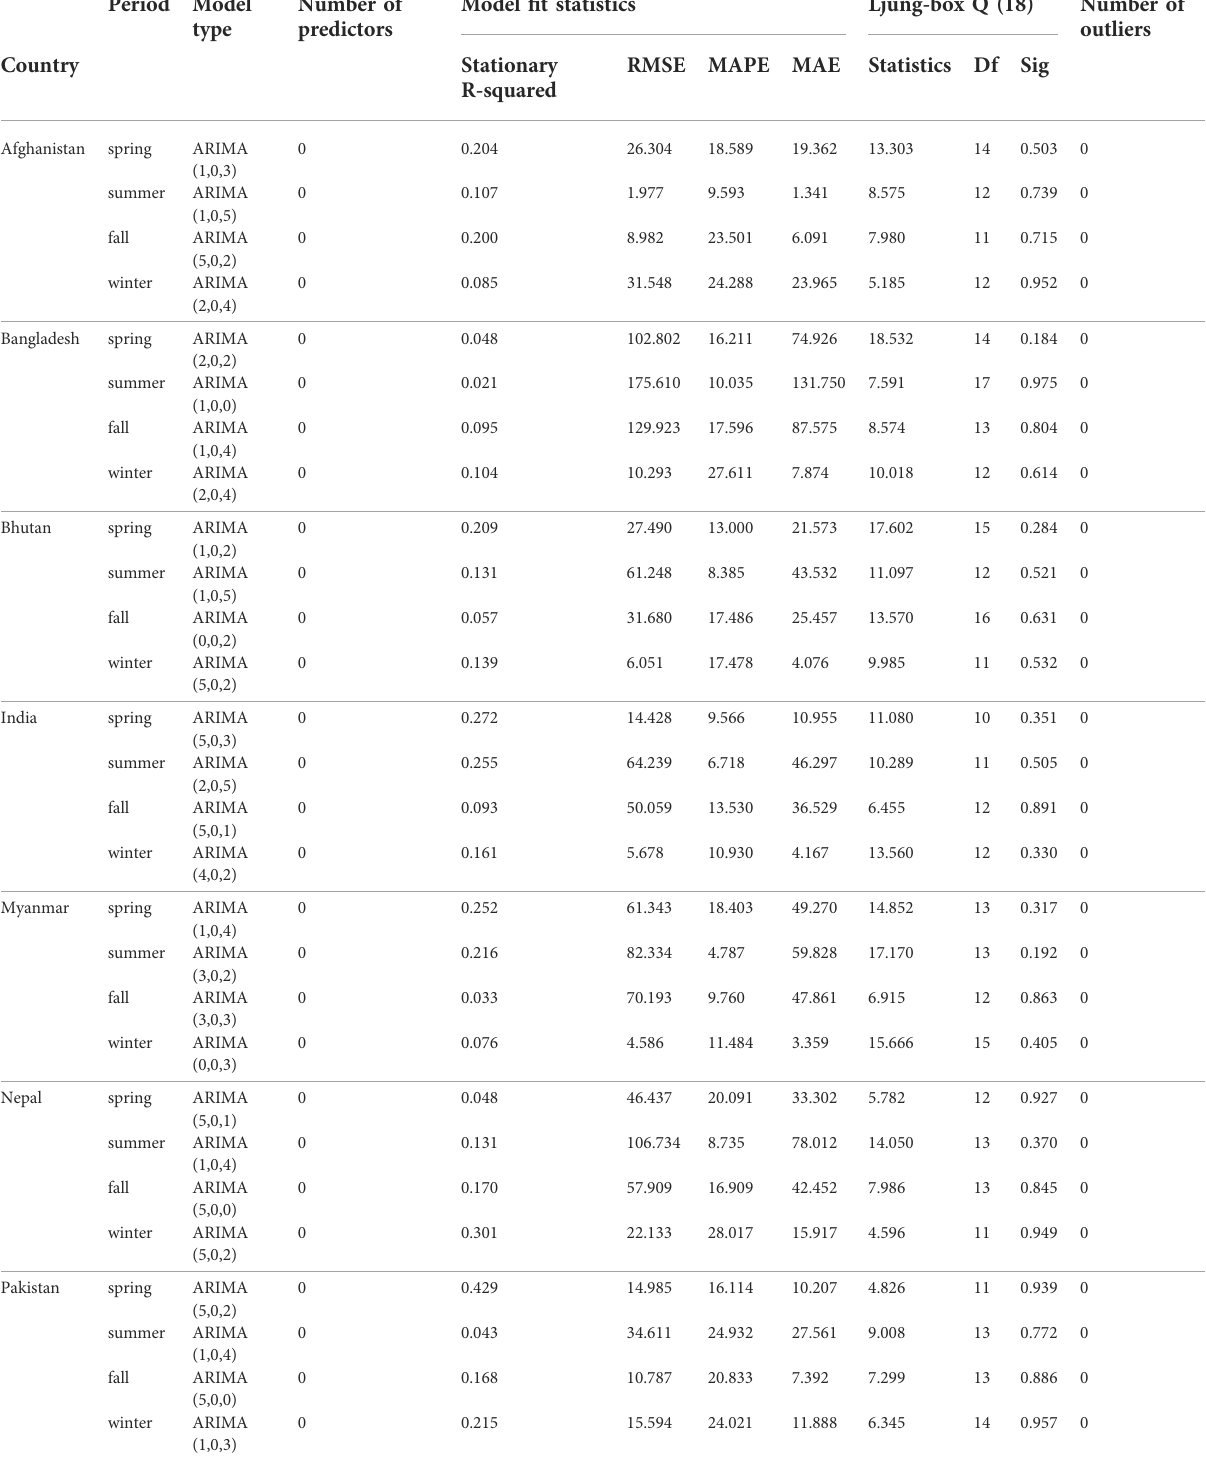
TABLE 4 Model statistics for mean seasonal precipitation for the countries of